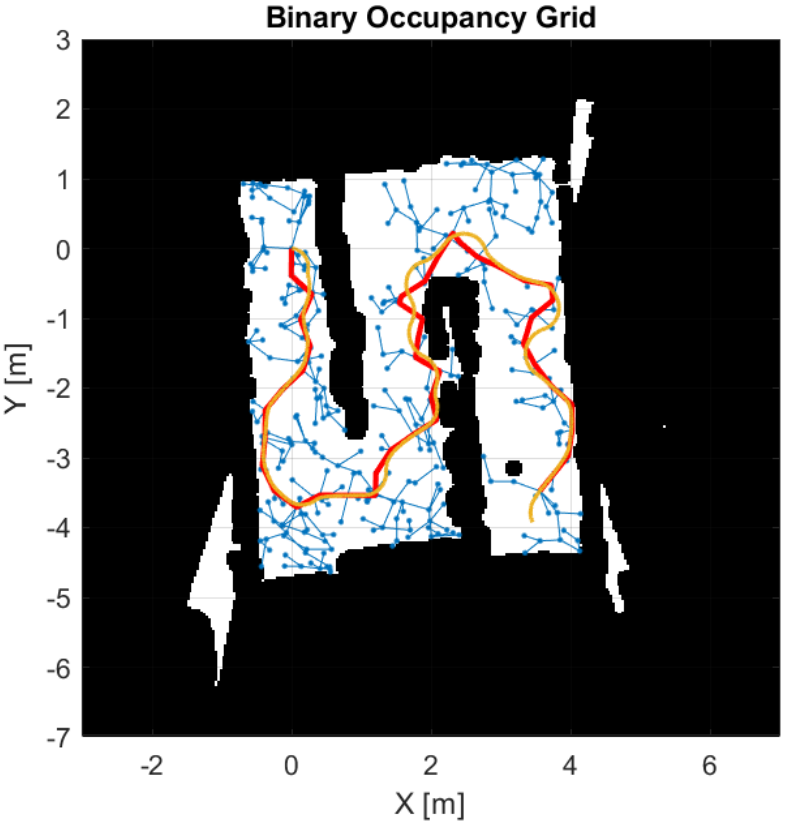
Figure 30. Desired waypoints obtained with RRT star algorithm and path obtained from odometry